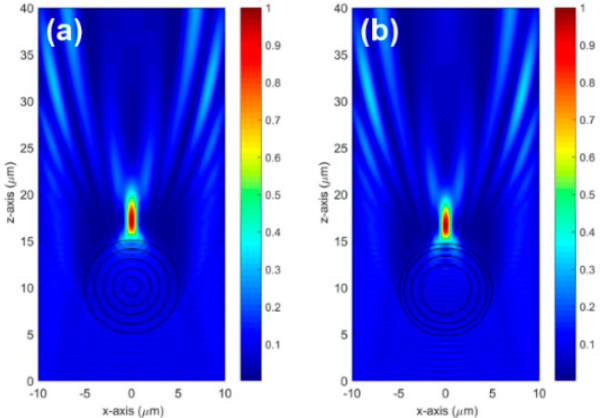
Figure 7. Intensity distributions of stepwise Luneburg lens with circular geometry for ( a ) the ELS and ( b ) EIS profiles shown in Figure 5. The intensities are normalized. Concentric circles depict the step boundary of the index profile.